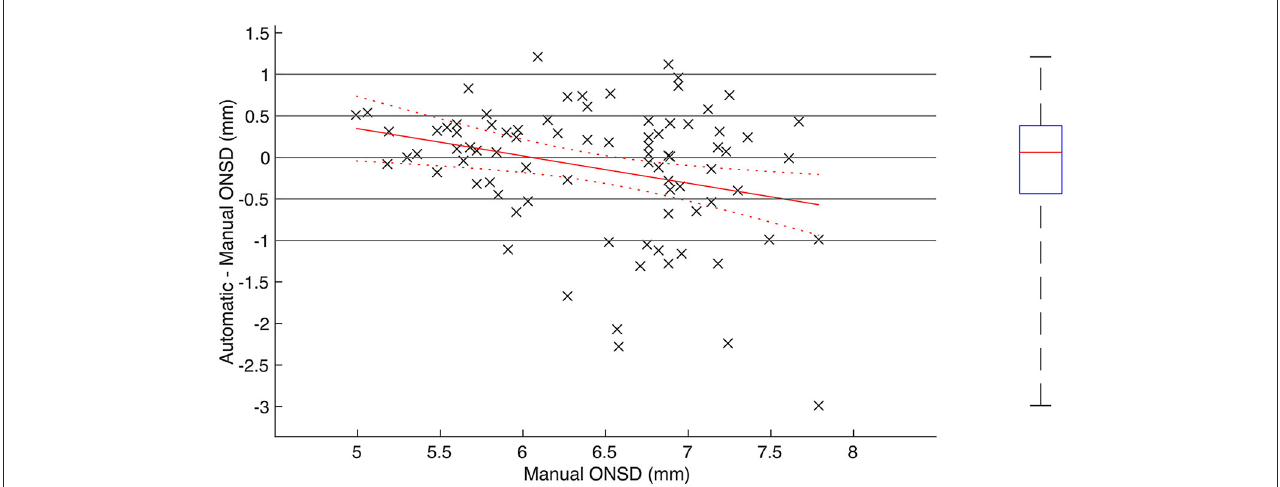
FIGURE2 Agreement between automatically and manually measured optic nerve sheath diameter. (Left) Scatterplot including regression line and associated confidence bounds showing pairwise difference between automatically and manually measured ONSD plotted against manually measured ONSD. (Right) Boxplot showing median, IQR and range of pairwise